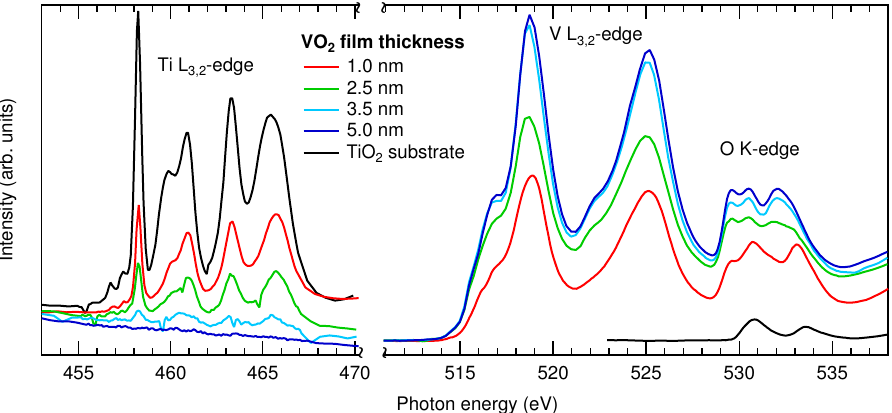
Figure 5. Ti L thickness and a TiO